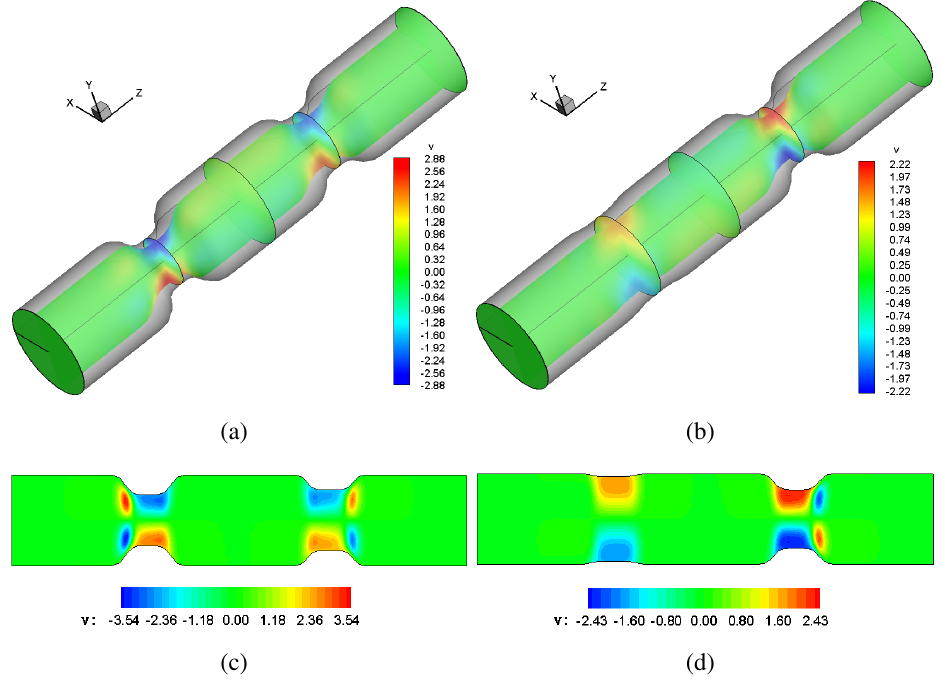
= 30 ◦ ; ( b ) 3D 12 = 30 ◦ ; ( d ) 2D theory at 12